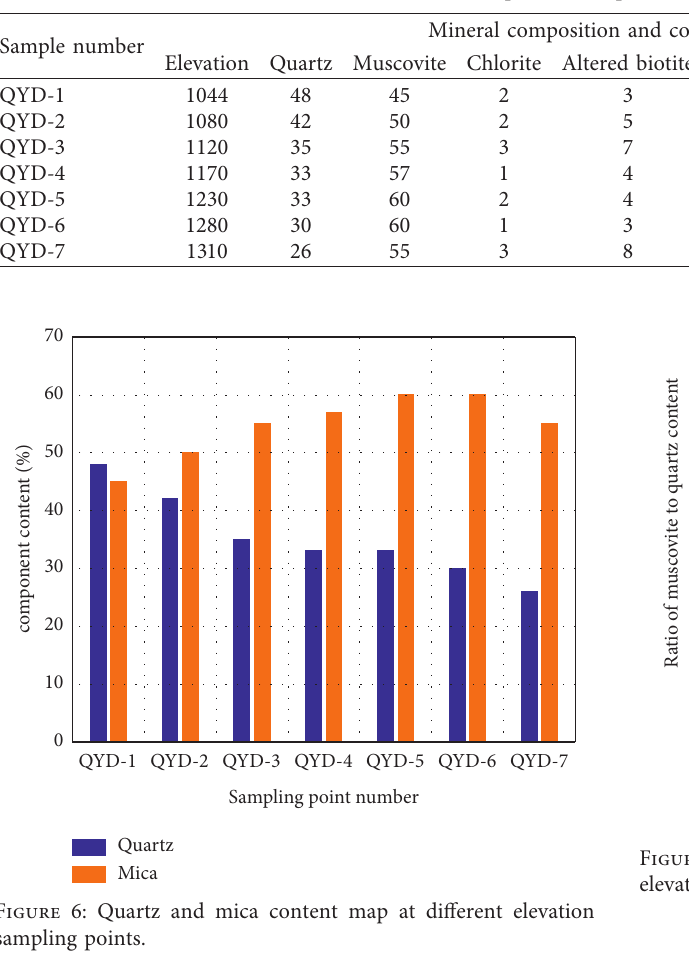
Table 3: Main mineral components of quartz mica schist at different elevations.